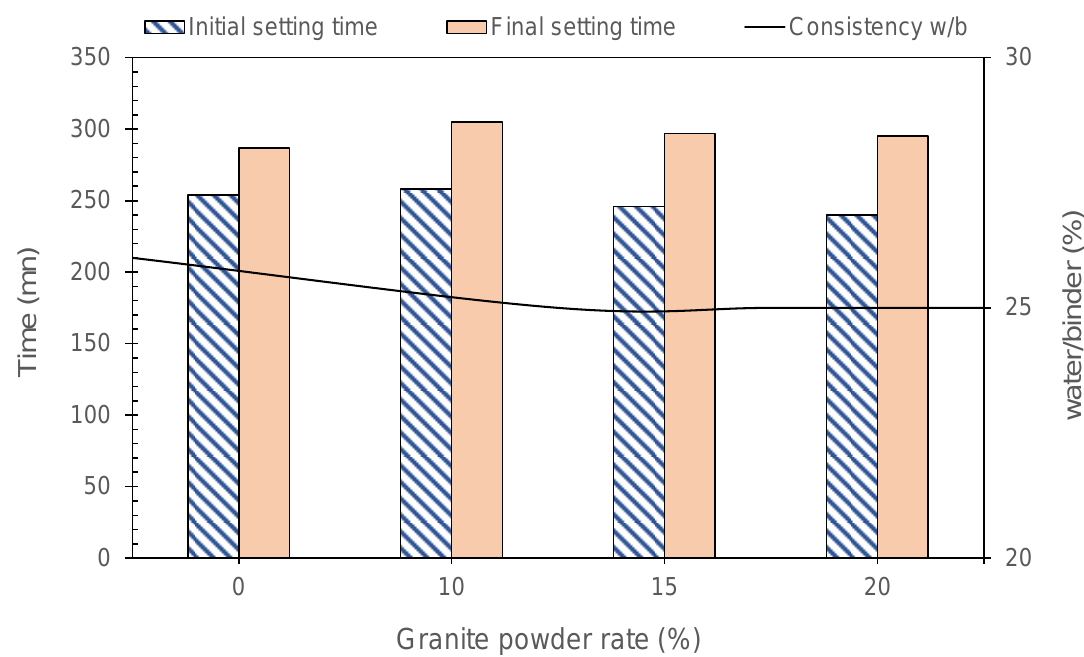
Figure 6. Water requirement, initial and final setting times of CEM I and GD pastes.